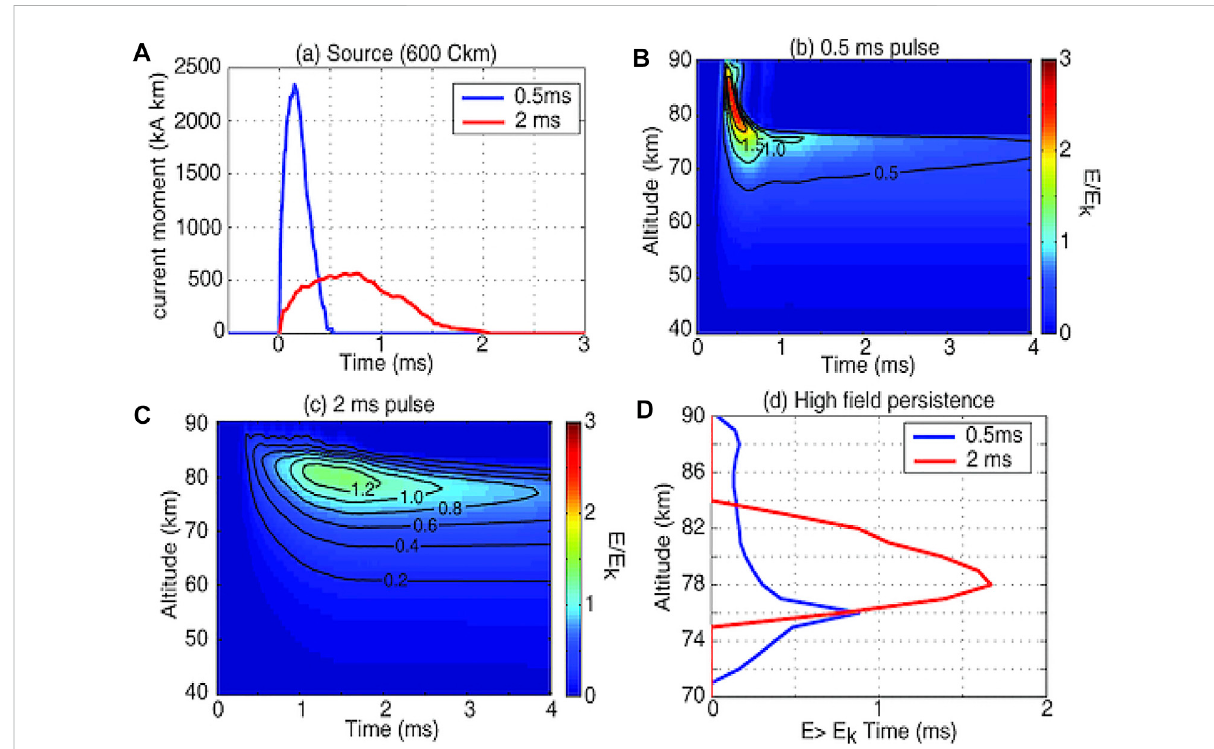
FIGURE 3 Comparison between two impulse charge transfer with different time scales to show the in fl uence of charge transfer timescale on the lightning-induced E- fi eld perturbation at the altitude of sprite initiation. The current moments with different time scales are shown in Panel (A) , and the lightning-induced E- fi eld perturbation associated with each case is shown in panels (B,C) , respectively. Panel (D) shows the persistent time for the lightning-induced E- fi eld to exceed the local E- fi eld threshold of dielectric breakdown at different altitudes. Adopted from Li et al.